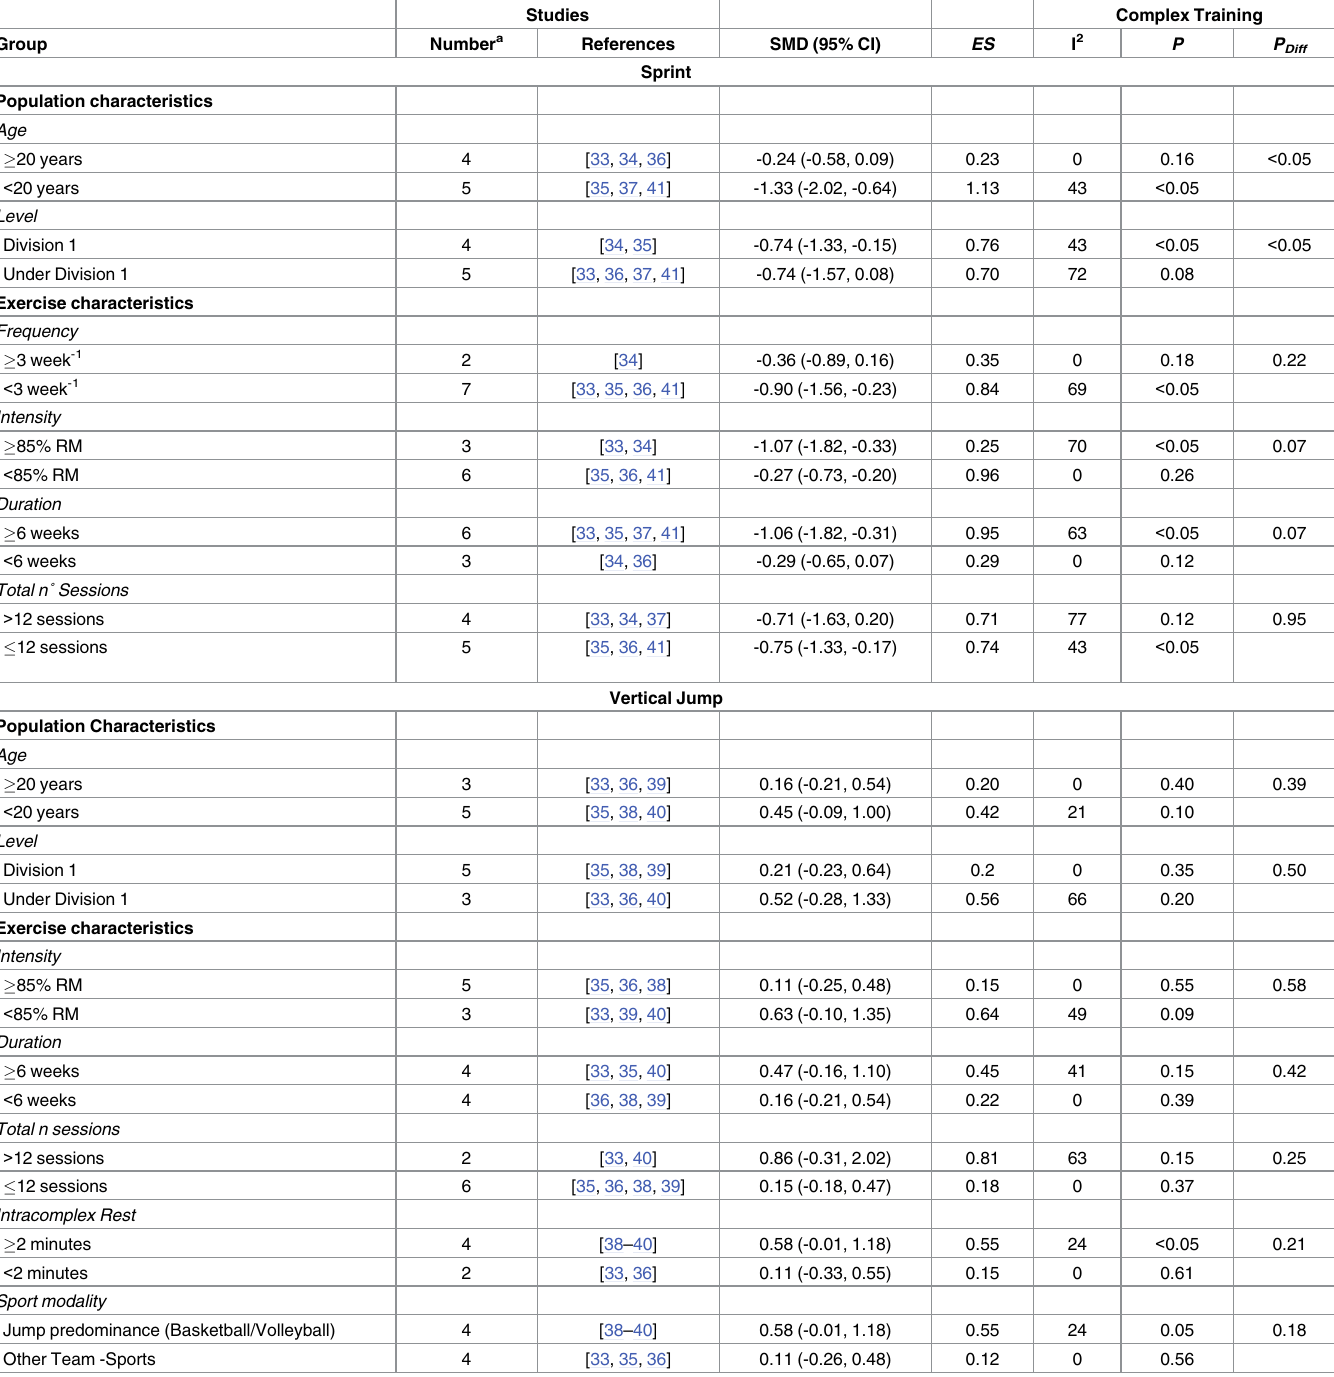
Table 3. Subgroup analyses assessing potential moderating factors for sprint time and vertical jump height in studies included in the meta-